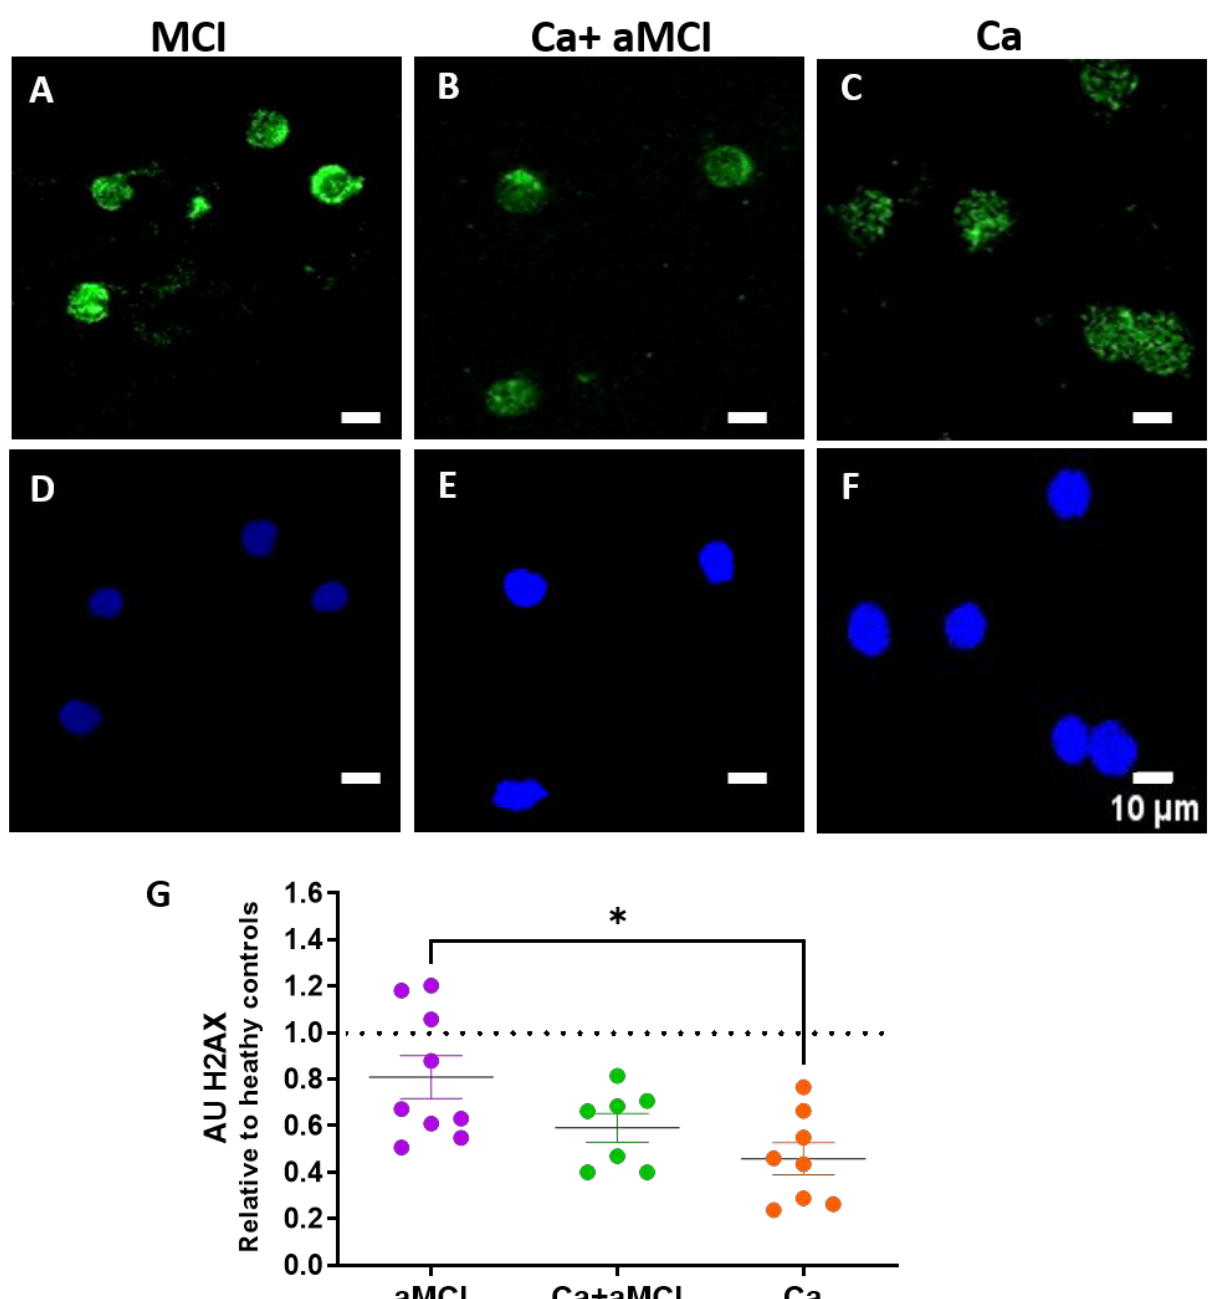
Figure 4. Activation of the DNA damage response, determined by immunofluorescence γ H2AX activity in PBMCs of aMCI, Ca + aMCI and Ca survivors. Representative immunofluorescence confocal images of γ H2AX staining (green, ( A – C )) and nuclei stained with DAPI (blue, ( D – F )) in PBMCs of representative aMCI ( A , D ), aMCI + Ca ( B , E ) and Ca survivor ( C , F ) patients. Scale bars: 10 µ m. ( G ): Immunofluorescence quantification of γ H2AX activity normalized by the number of nuclei in aMCI (n = 9), aMCI + Ca (n = 7) and Ca survivor (n = 8) patients. γ H2AX levels were decreased in PBMCs of Ca survivors compared with aMCI patients and healthy controls (dotted line; p < 0.05. Healthy controls had 12330 ± 608, mean ± SE, fluorescent arbitrary Units); those of Ca + aMCI patients were also decreased, although non-significantly. Around 98 to 100% of analyzed nuclei were positive for γ H2AX without major differences between the different groups. Statistical analysis: Kruskal–Wallis with Dunn’s post hoc correction, * p < 0.05.